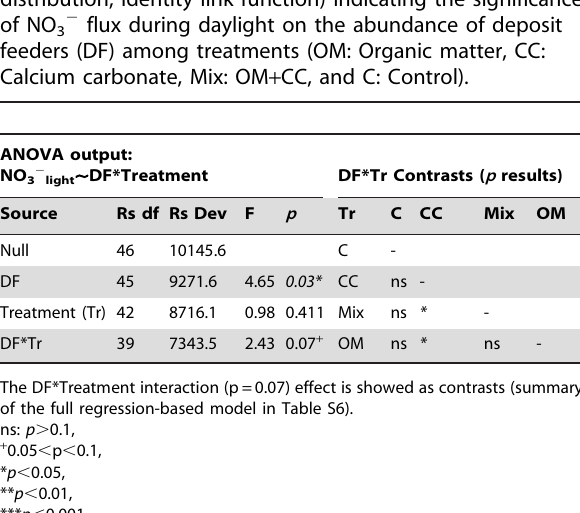
Figure S1 Boxplots on sediment characteristics: chlo- rophyll a ( m g.g-1 sediment), organic matter (%), and macrofauna community abundance (number of individ- uals) and Shannon’s diversity index (H 9 ) through the four treatments (Calcium carbonate, Control, Mix and Organic matter).